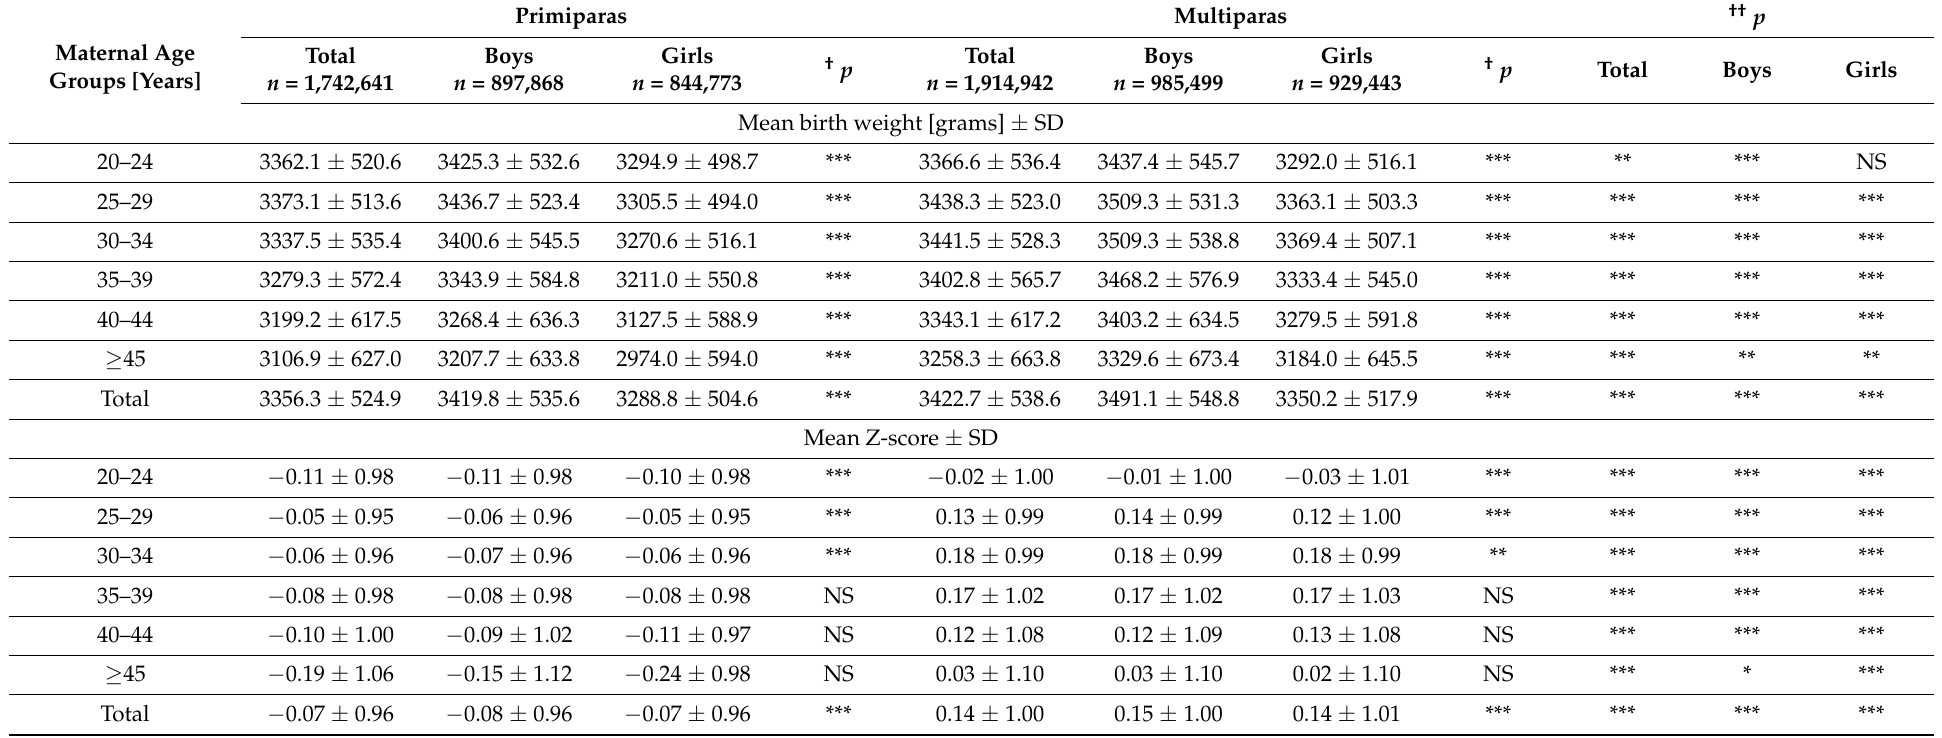
Table 2. Distribution of birth weight in relation to maternal age stratified by parity and sex of